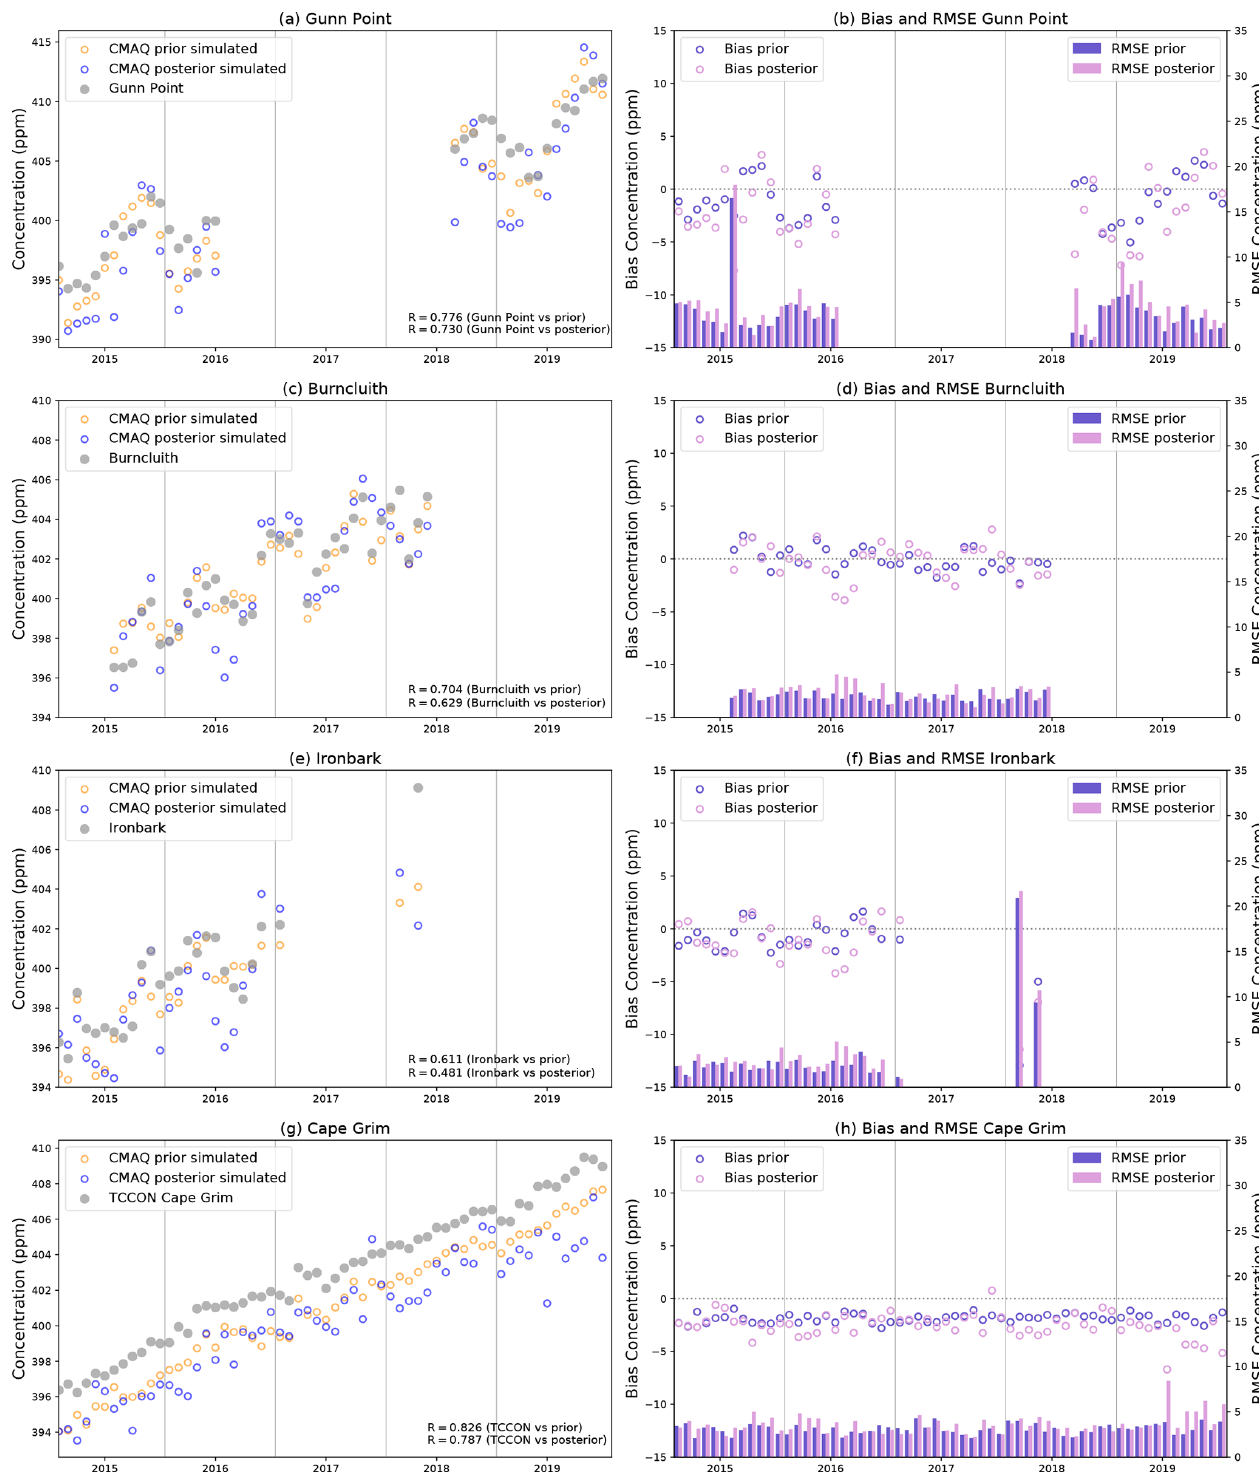
Figure 8. Comparison between monthly mean CO 2 concentrations (ground-based stations) at the (a) Gunn point, (c) Burncluith, (e) Ironbark, and (g) Cape Grim sites and the CMAQ prior and posterior modelled CO 2 concentrations for 2015–2019. Bias and root-mean-square error (RMSE) between the model and observations are shown in panels (b) , (d) , (f) , and (h) . The purple and violet circles in the aforementioned panels represent the respective prior and posterior concentration biases, and the purple and violet bars represent the respective prior and posterior RMSE